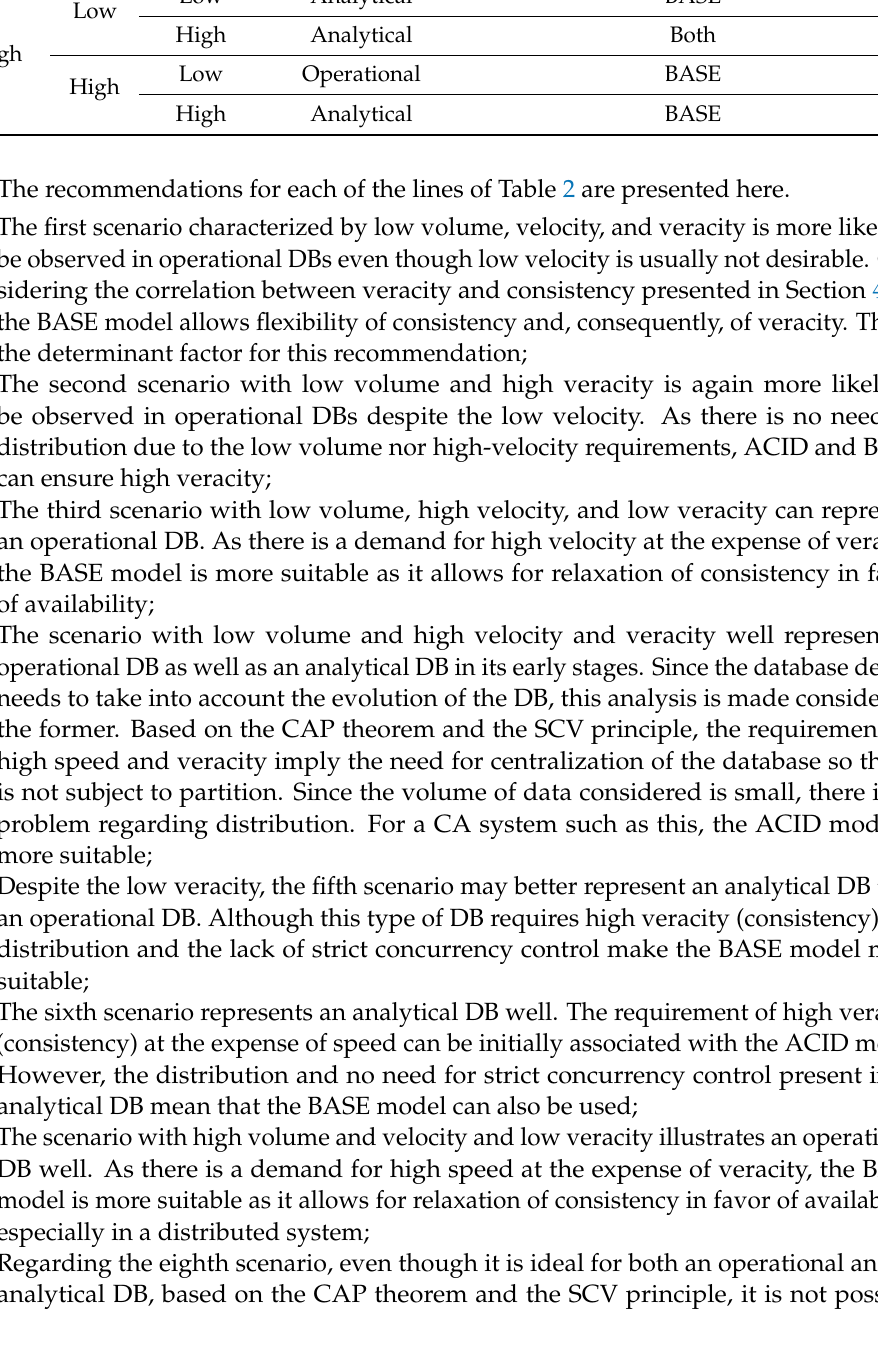
The recommendations for each of the lines of Table 2 are presented